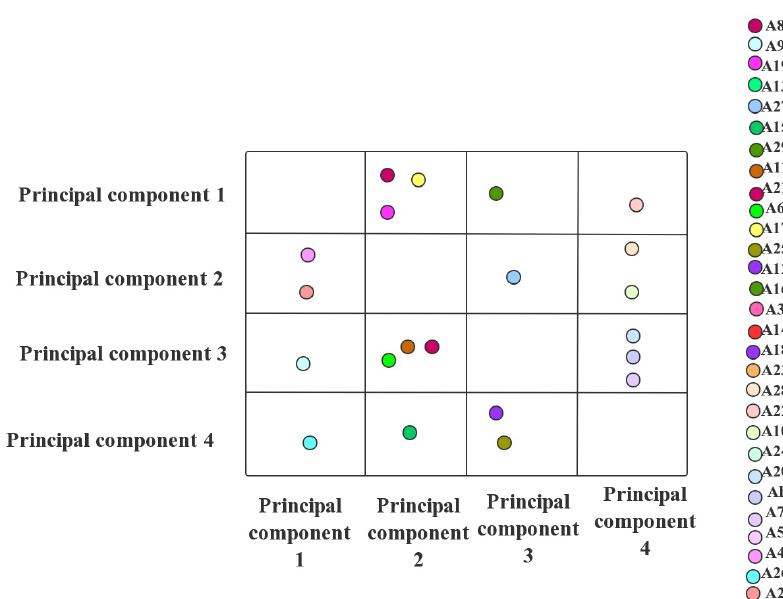
Fig. 2 Broken line diagram.